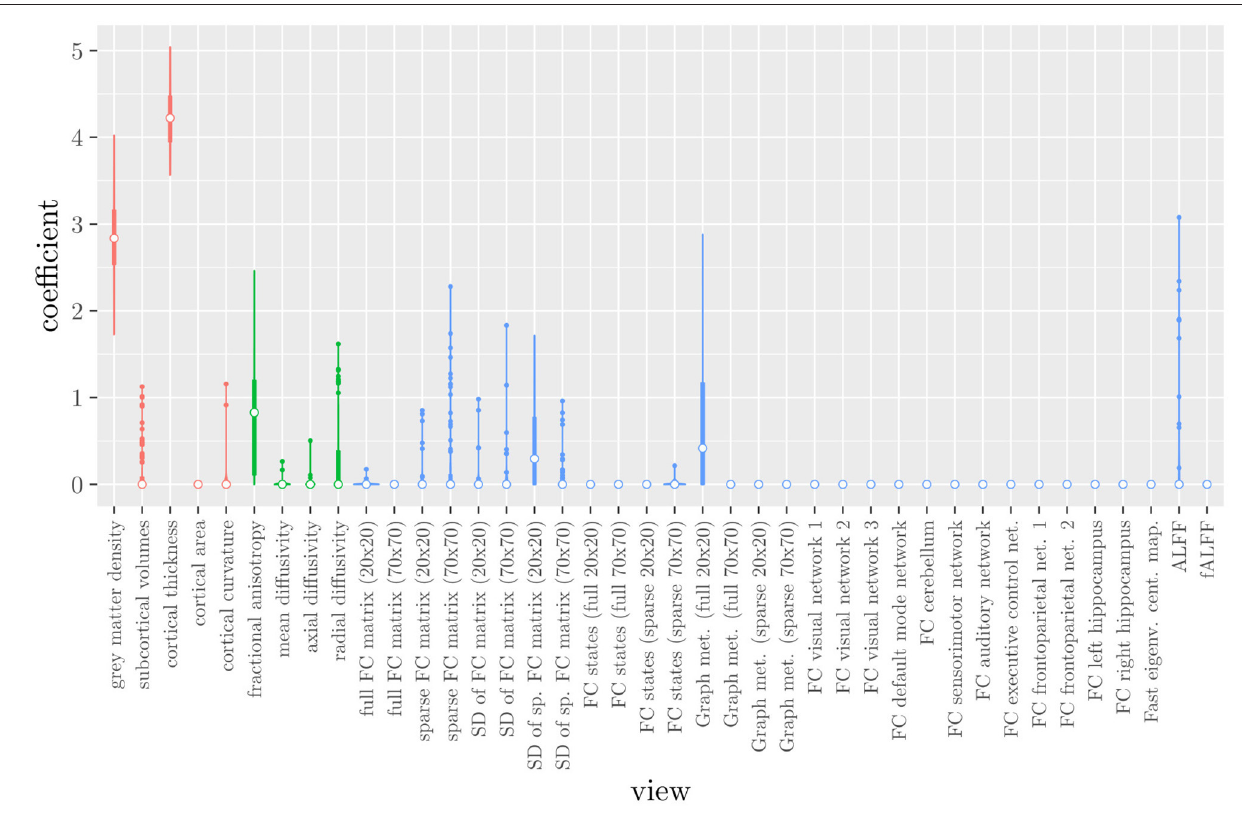
accuracy was 0.893 (SD = 0.008), which was also higher than